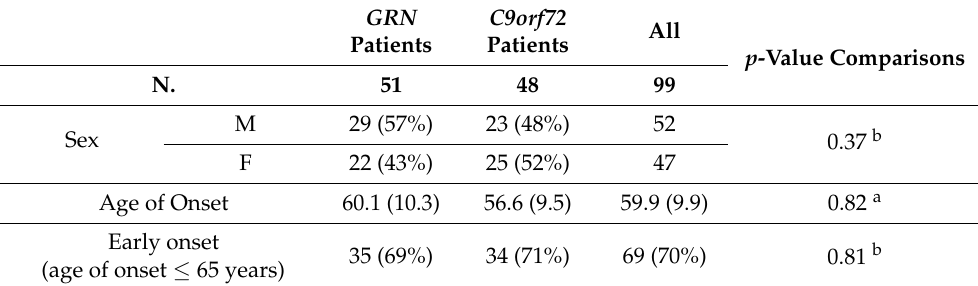
Table 2. Clinicalanddemographiccharacteristicsofpatientsincludedinthesinglevariantassociationanalysis.